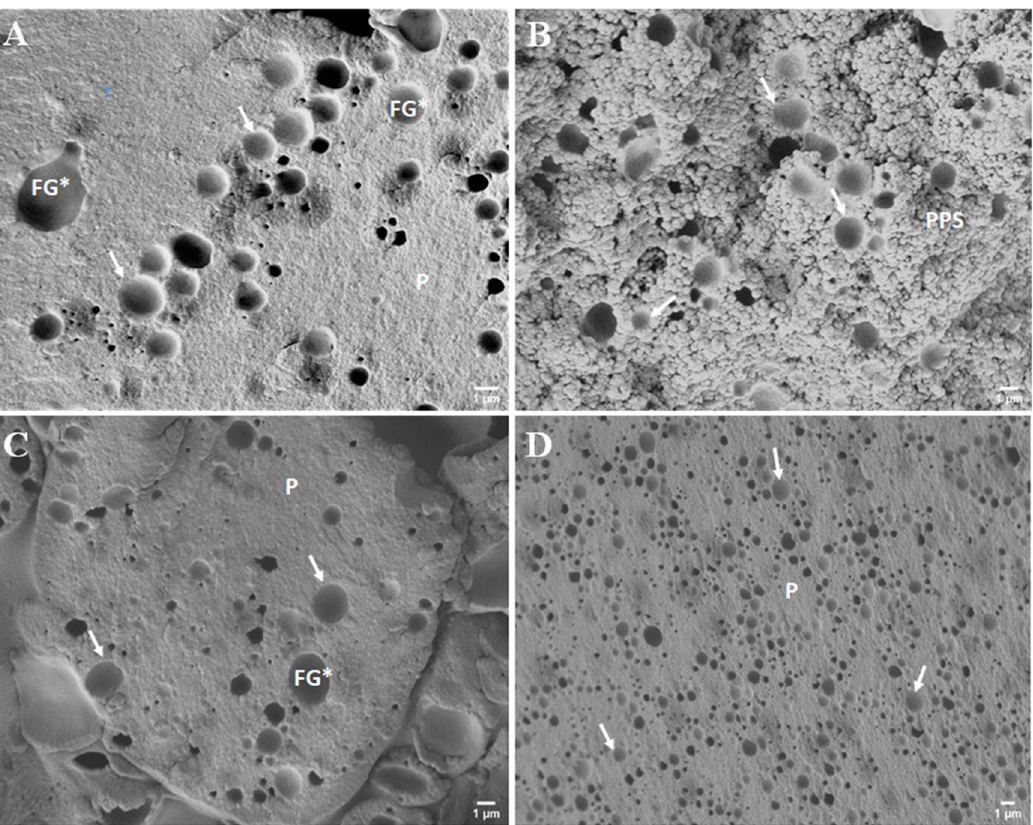
Figure 4. Scanning electron microscopy images of the model processed cheese (the scale bars represent 1 μ m; 5000× magnification). ( A ) Sample with agar; ( B ) sample with κ‐ carrageenan; ( C ) sample with gelatin; ( D ) sample with emulsifying salts; FG* (and white arrows)—void space of fat globules; P—protein structure; PPS—protein ‐ polysaccharide structure.